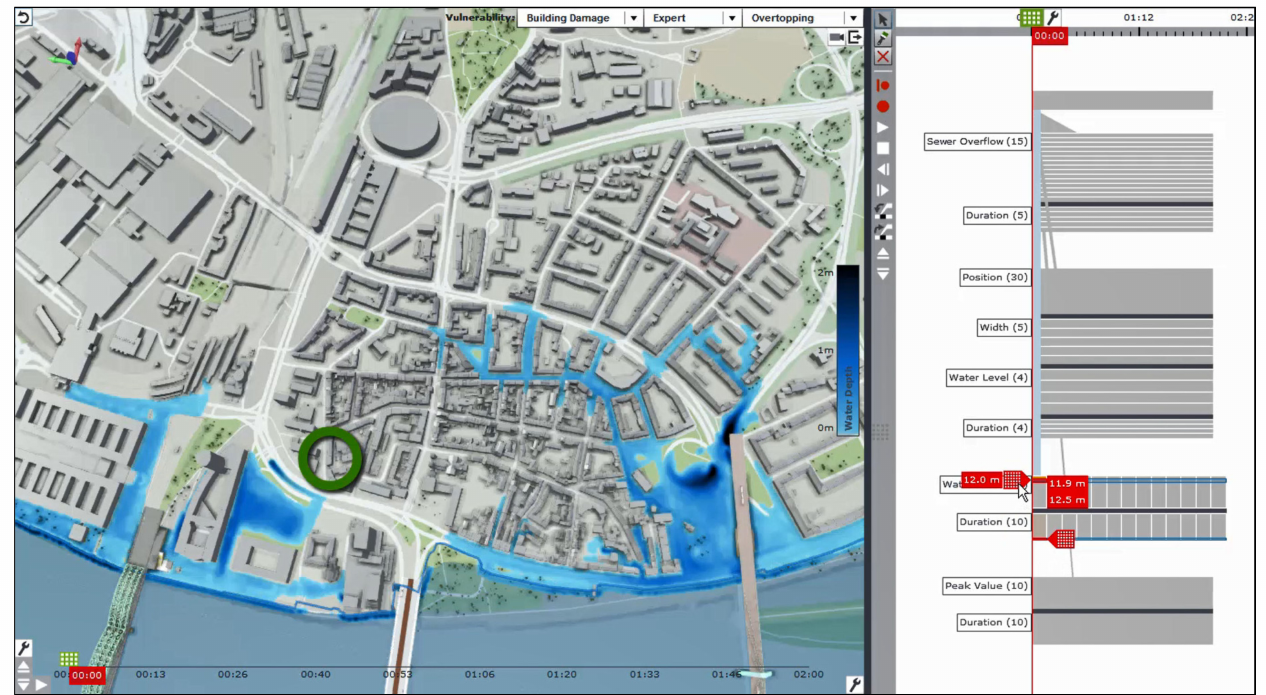
Figure 12. Selection of different floodwall overtopping scenario from the parameter-based and time- based world lines (green circle marks the building of interest). In this illustration, a water level of 12 m was selected and the resulting flooding scenario visualized for selected overtopping duration.